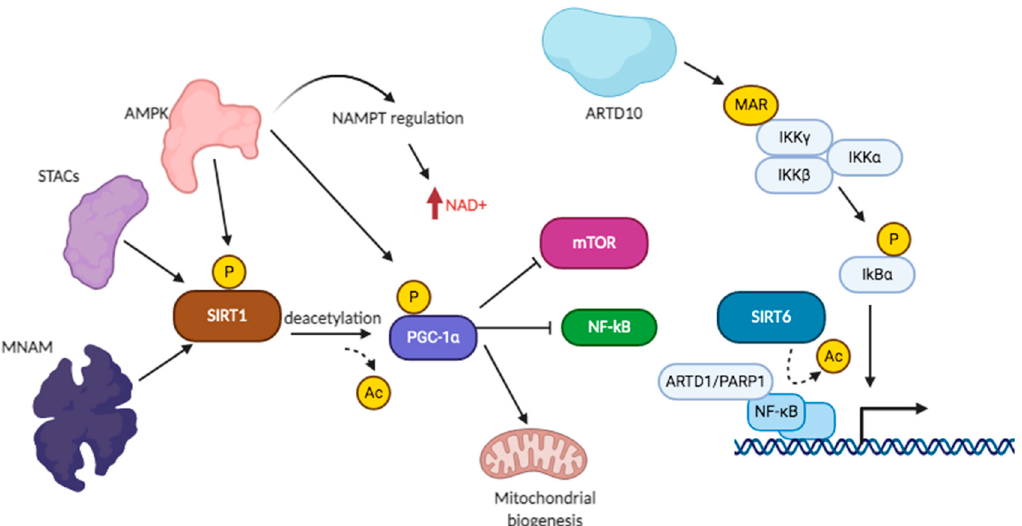
Figure 2. Sirtuin and ART signaling converging on NF-kB regulation.